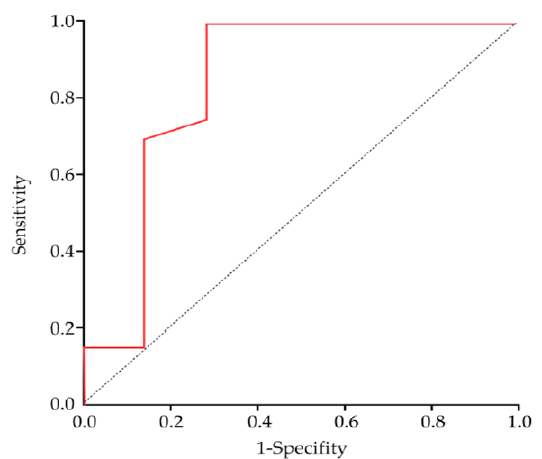
Figure 5. Receiver operating characteristic (ROC) curves of the R20 improvement